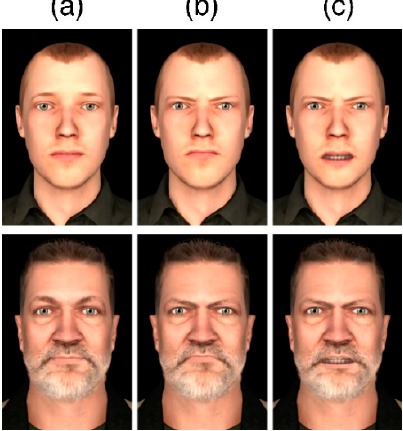
Figure 1. Two exemplary characters from the pool of avatars used in the study, each in all three conditions.